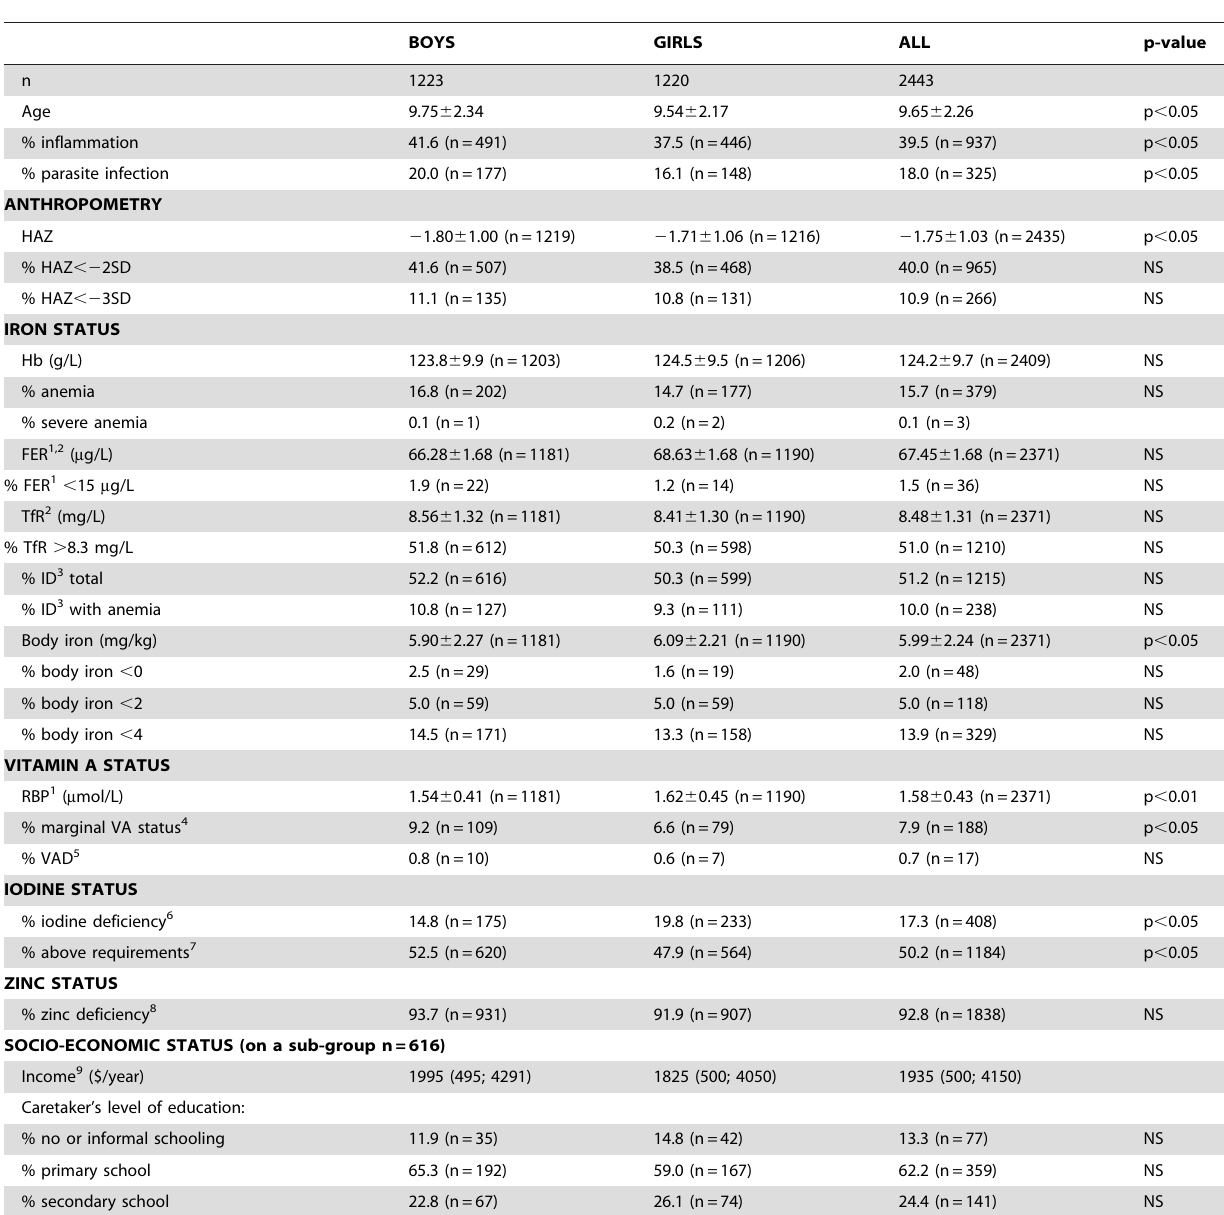
Table 1. Characteristics of school-children participating in the